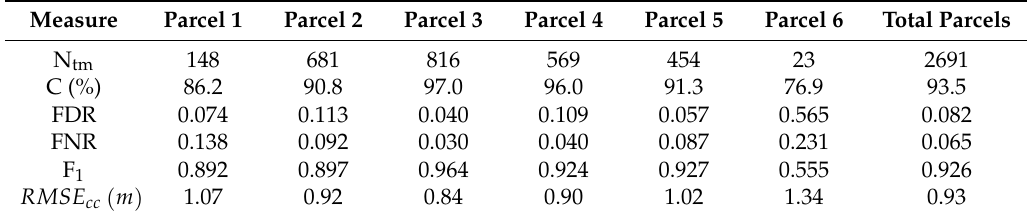
Table 7. Data quality measures results for